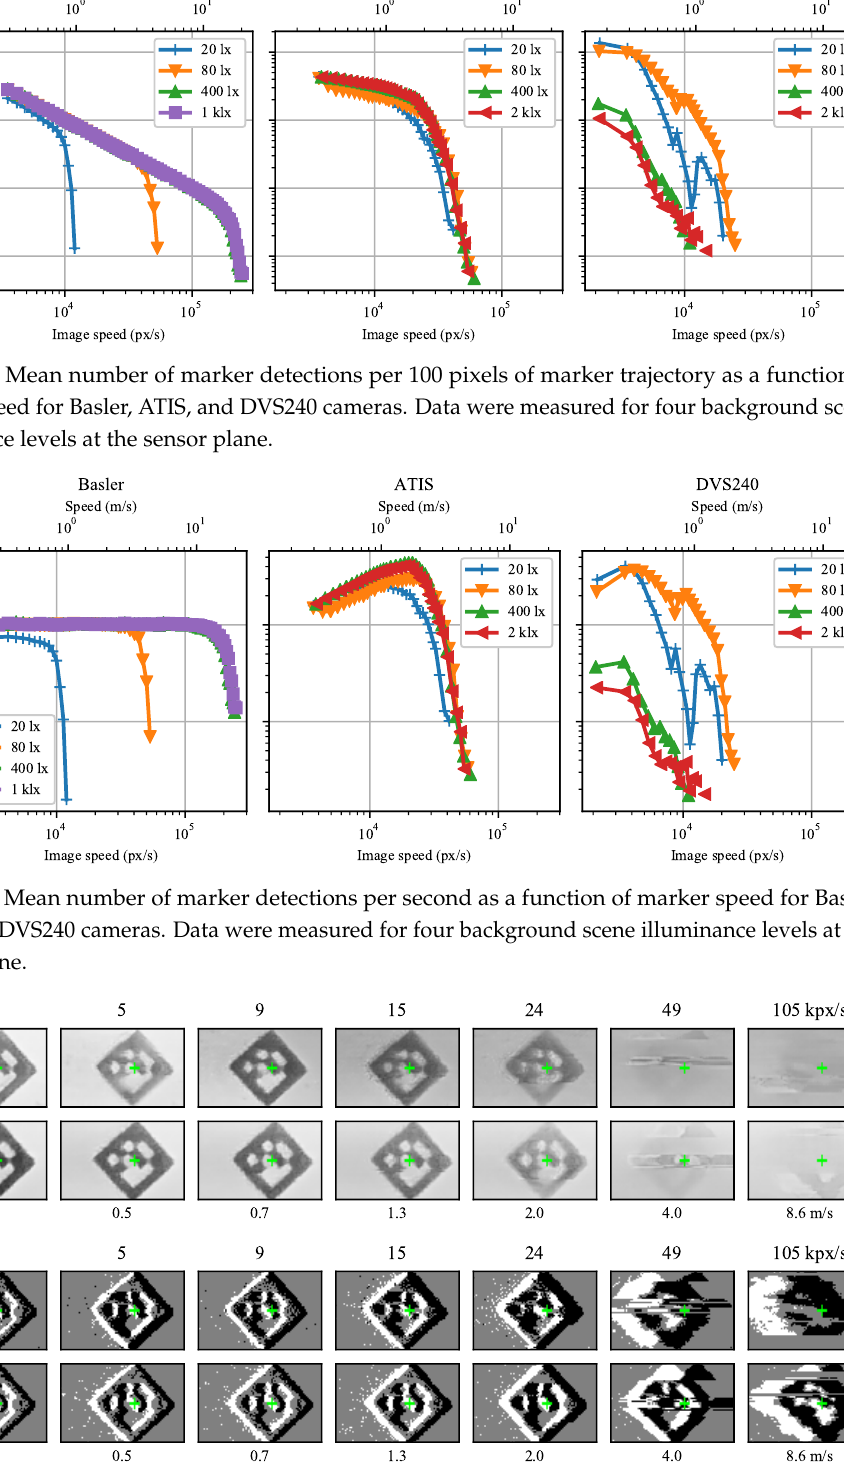
Figure 12. Sample reconstructed intensity and event marker images from the ATIS sensor. The images are shown for two illuminance levels at the sensor plane and seven image ( top )/metric ( bottom ) speeds. The green crosses indicate the ground truth position of the marker